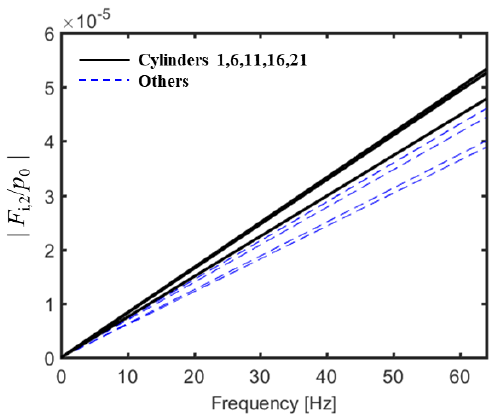
Figure 7. Amplitudes of pressure forces acting on the multiple cylinders caused by pressure scattering wave.